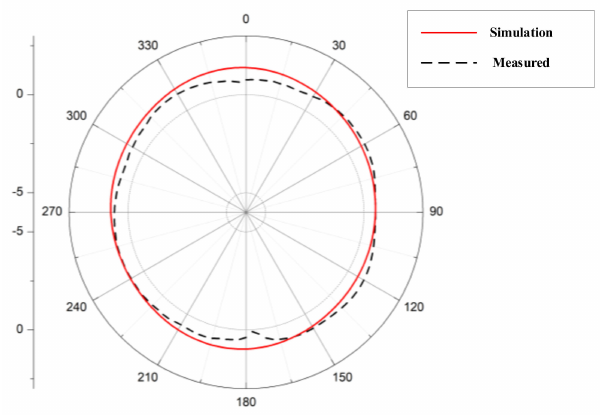
Figure 17. Measured and simulated pattern of receiving antenna.